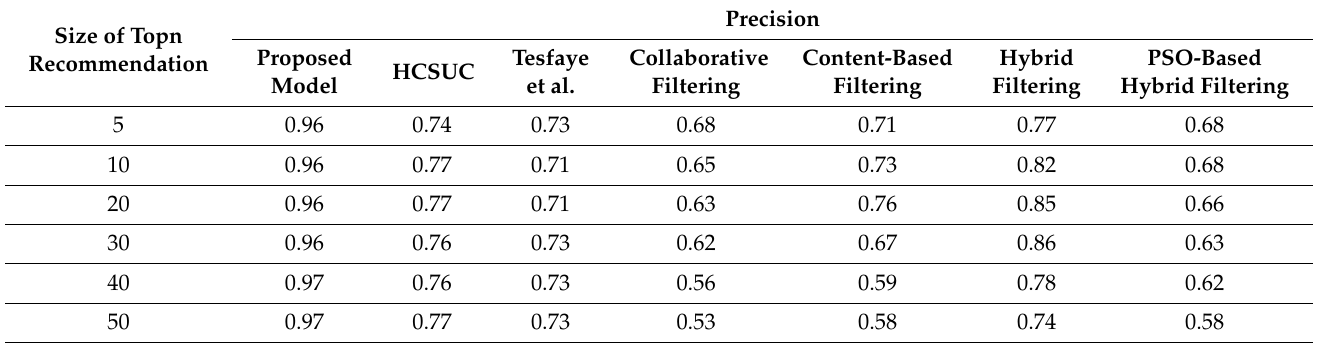
Table 11. Precision according to the Topn Recommendation (Considering Dataset 3 [45]).